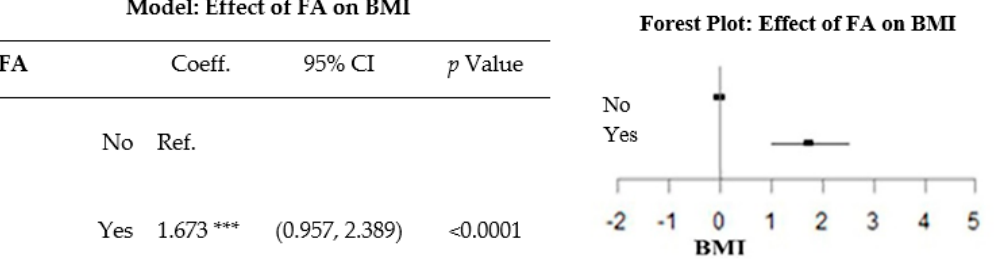
Figure 2. Effect of food addiction (FA) on the body mass index (BMI) after adjustment for sociodemographic variables. The model was obtained from a multiple linear regression, and was adjusted for sex, age group, employment status, and educational attainment. *** p -value < 0.0001. Coeff., coefficient; CI, confidence interval; Ref., reference.